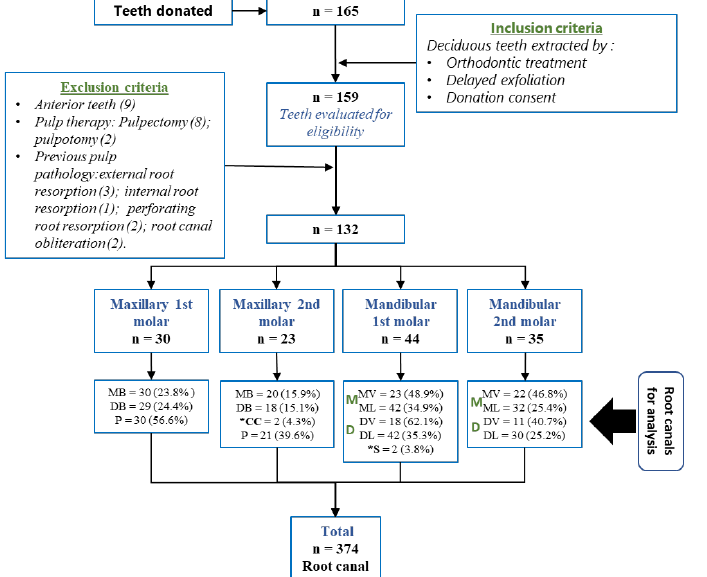
Figure 6. Recruitment and sample distribution. MB (mesiobuccal canal); ML (mesiolingual canal); DB (distobuccal canal); DL (distolingual canal); S* (supernumerary root canal), *CC (collateral canal).